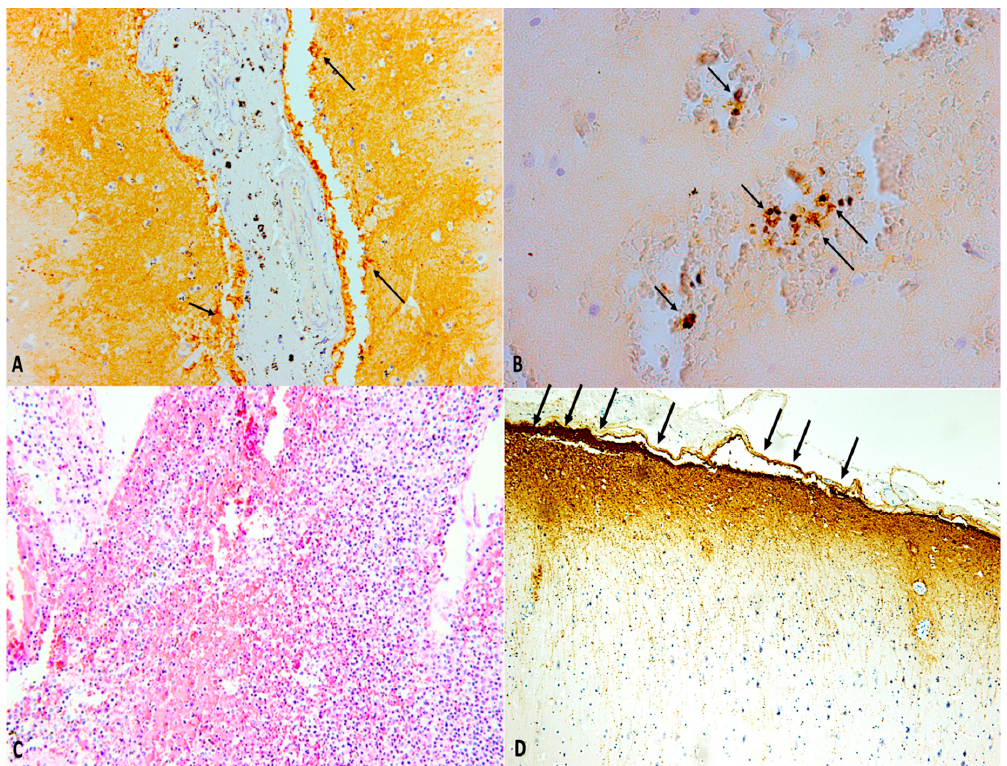
Figure 6. ( A – B ) Immunohistochemistry of both brain and meninges allows dating of the traumatic event post traumatic brain injury. ( A ) Aquaporin-4 (AQP4) and ( B ) hypoxia induced factor-1 α (HIF-1 α ) immunopositivity (black arrows) in post-traumatic meningitis after traumatic brain injury (30-day survival) ( × 40 and × 100, respectively). ( C ) Post-traumatic meningitis: histological staining of the brain and meningeal tissues showing strong inflammatory response (hematoxylin and eosin (H&E), × 60). ( D ) Glial fibrillary acid protein (GFAP) showed its highest expression in post-traumatic meningitis after traumatic brain injury, a definite thickening of the meningeal lining (black arrows) is clearly observable (30-day survival) ( ×